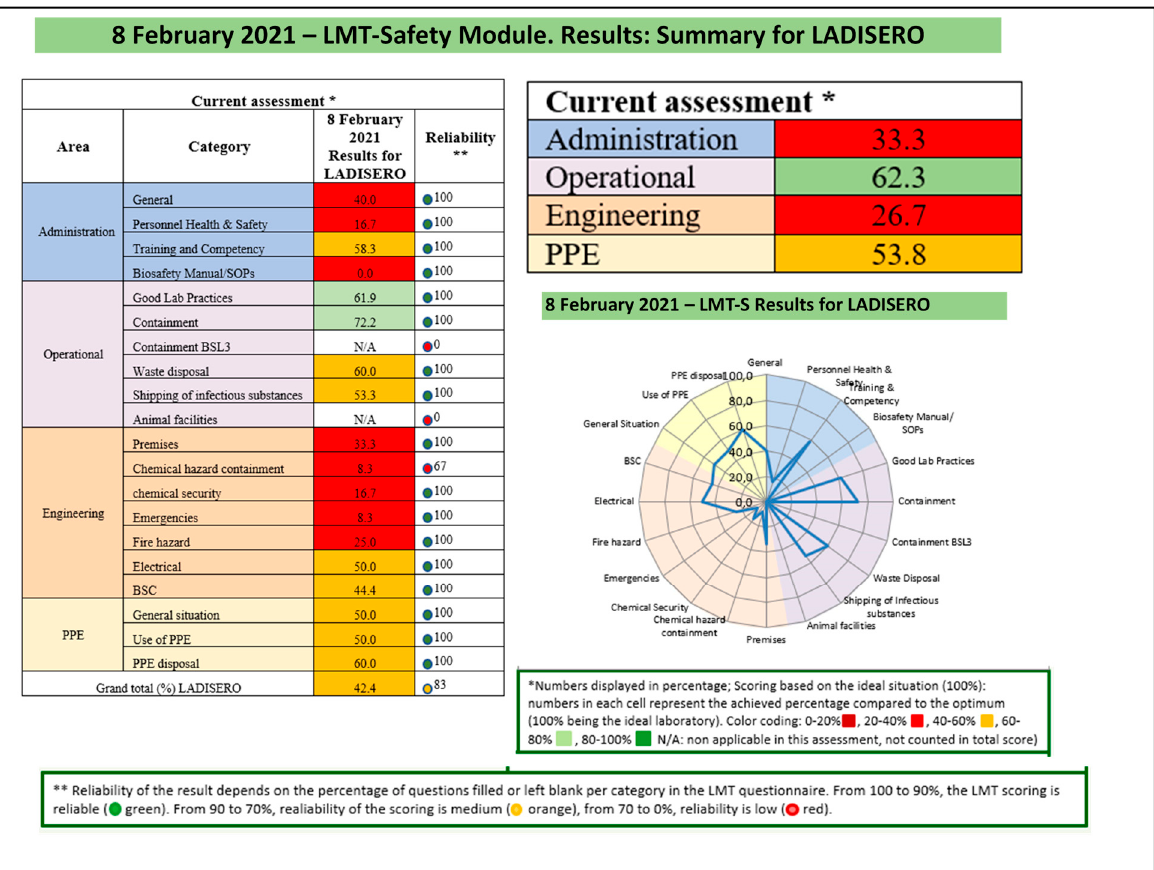
Figure 2. Results of the biosafety and biosecurity assessment in the reference veterinary laboratory of Parakou (LADISERO), Benin, February 2021.